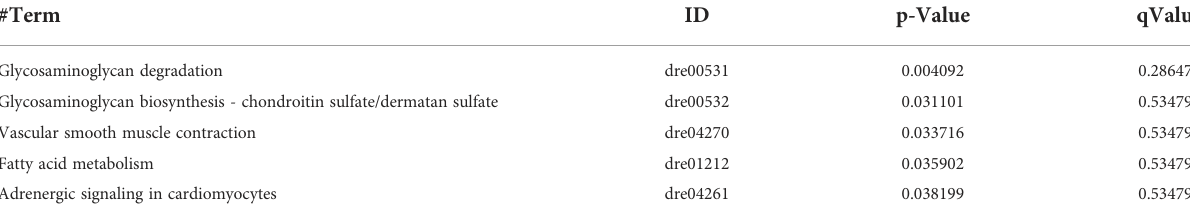
TABLE 1 Enriched KEGG pathways for the genes in selective sweeps simultaneously identi fi ed by XP-CLR, F ST and nucleotide diversity measurements. #Term ID Glycosaminoglycan